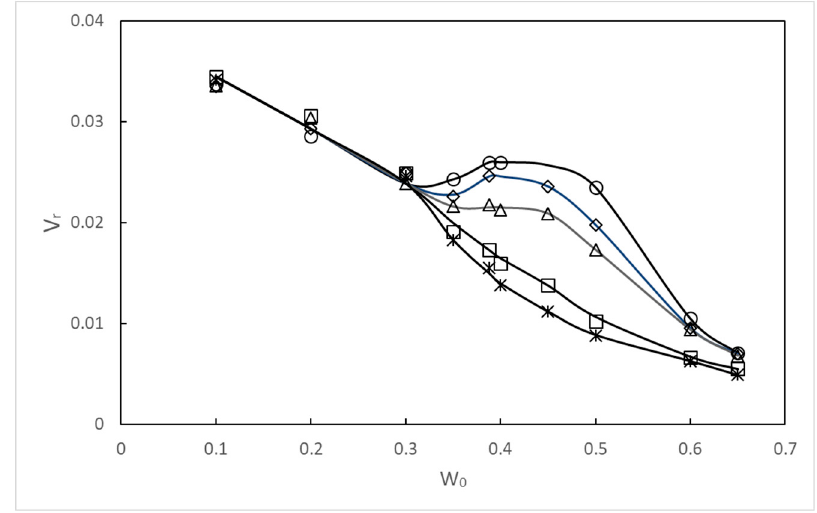
Figure 2. Reduced volume V r of polyacrylamide gel immersed in the binary mixture isobutyric acid— water at different weight fractions of isobutyric acid W 0 and temperatures of 26.4 °C ( ○ ), 27.0 °C ( ◇ ), 28.0 °C ( △ ), 35.0 °C ( □ ), and 45.0 °C ( * ).